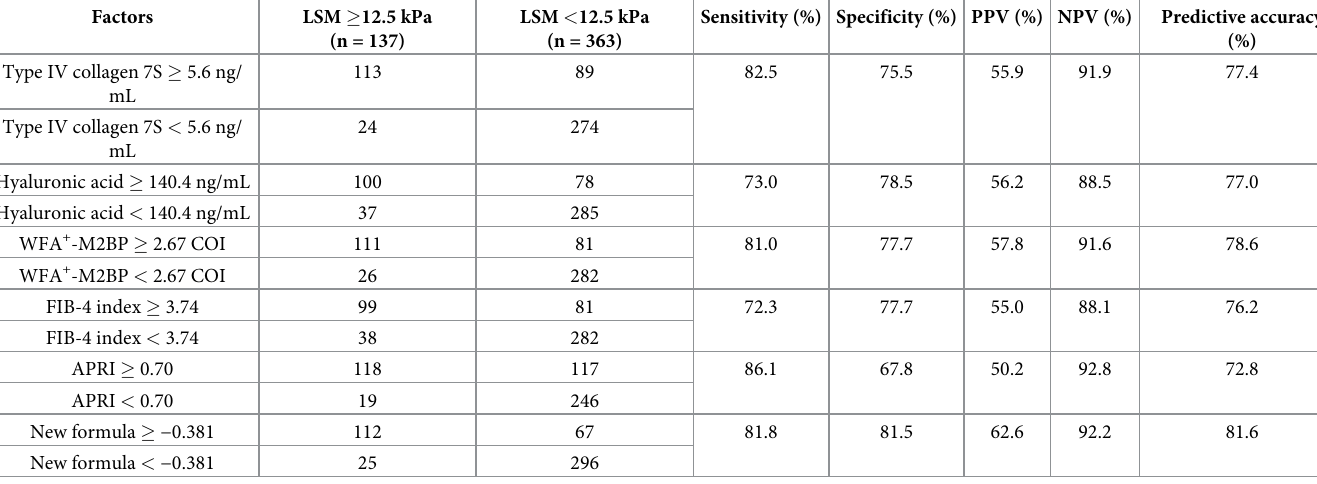
Table 3. Diagnostic performance of fibrosis markers and formulae for predicting LSM � 12.5 kPa (liver cirrhosis) in the training